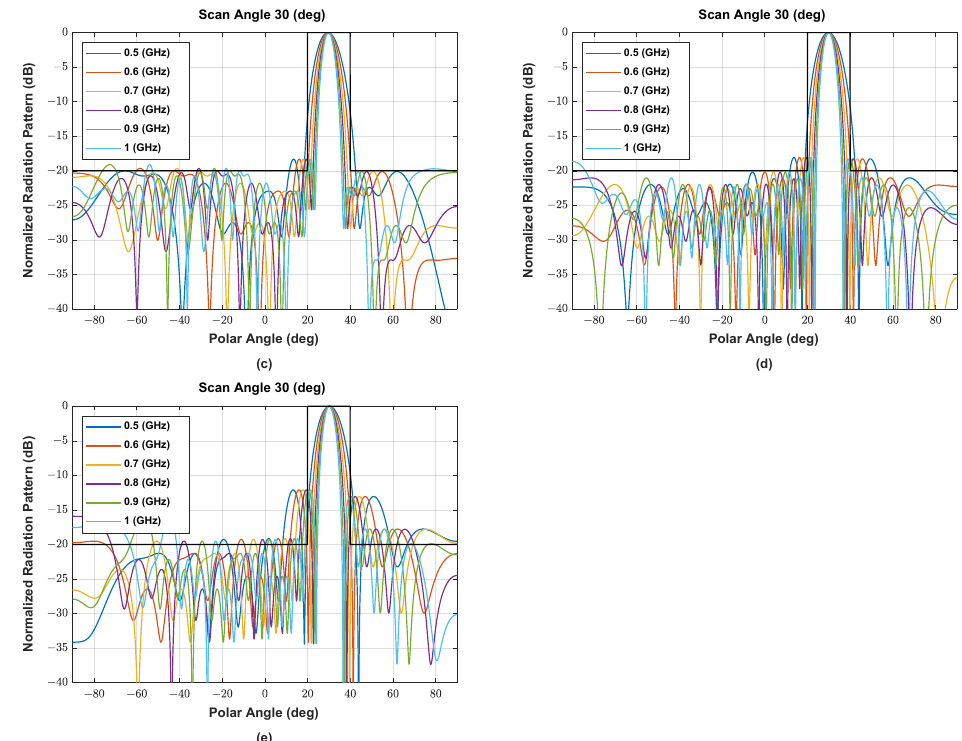
Figure A5. The beam pattern of asymmetric NUSLA using ( a ) MORELA, ( b ) QPSO, ( c ) FA, ( d ) SSA, and ( e ) MALO in case for θ 0 = 30°.